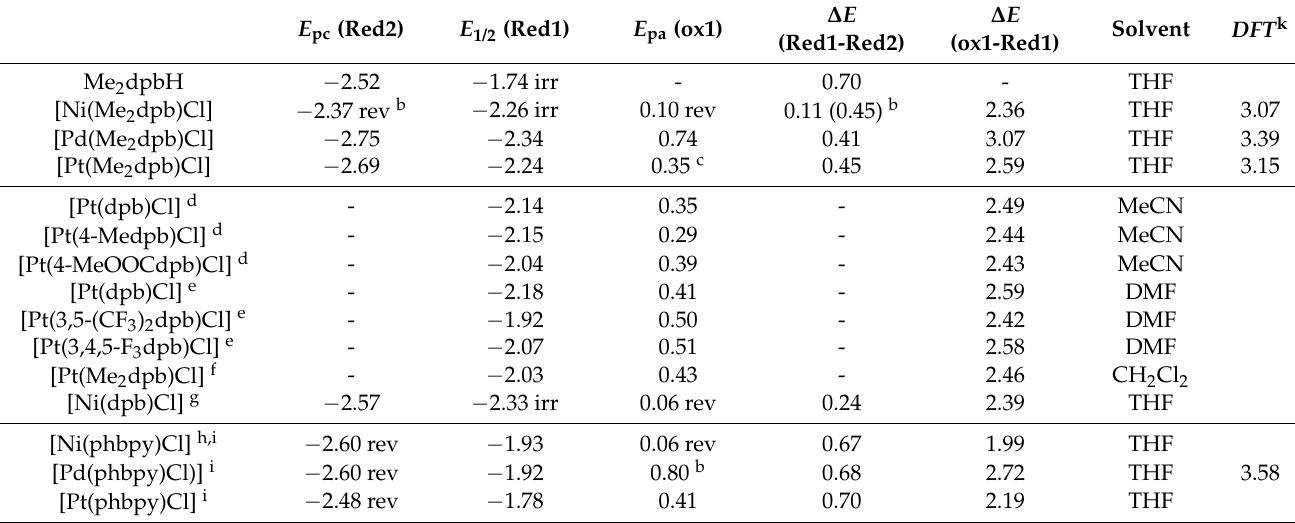
Table 1. Redox potentials of Me 2 dpbH, of complexes [M(Me 2 dpb)Cl] (M = Pt, Pd, Ni), and of comparable complexes a